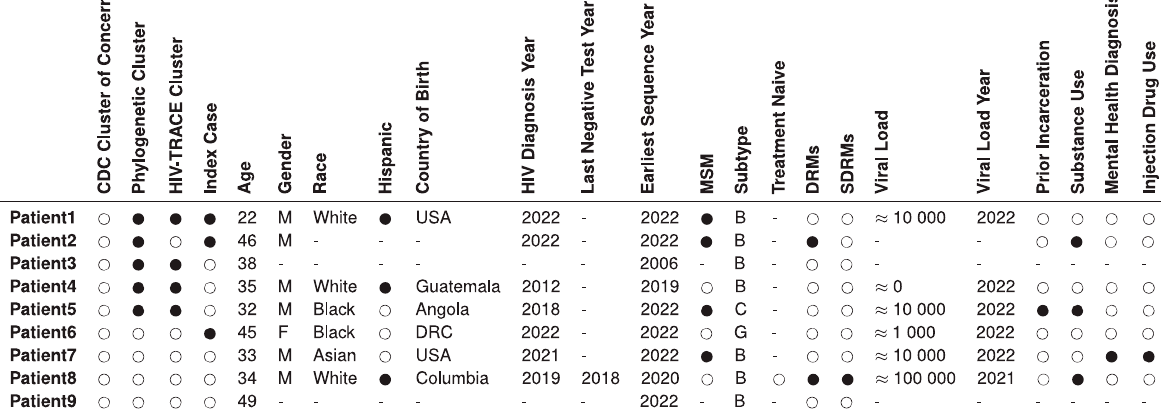
Figure 1. Title: Integrated report for monthly academic-public health case management meetings.